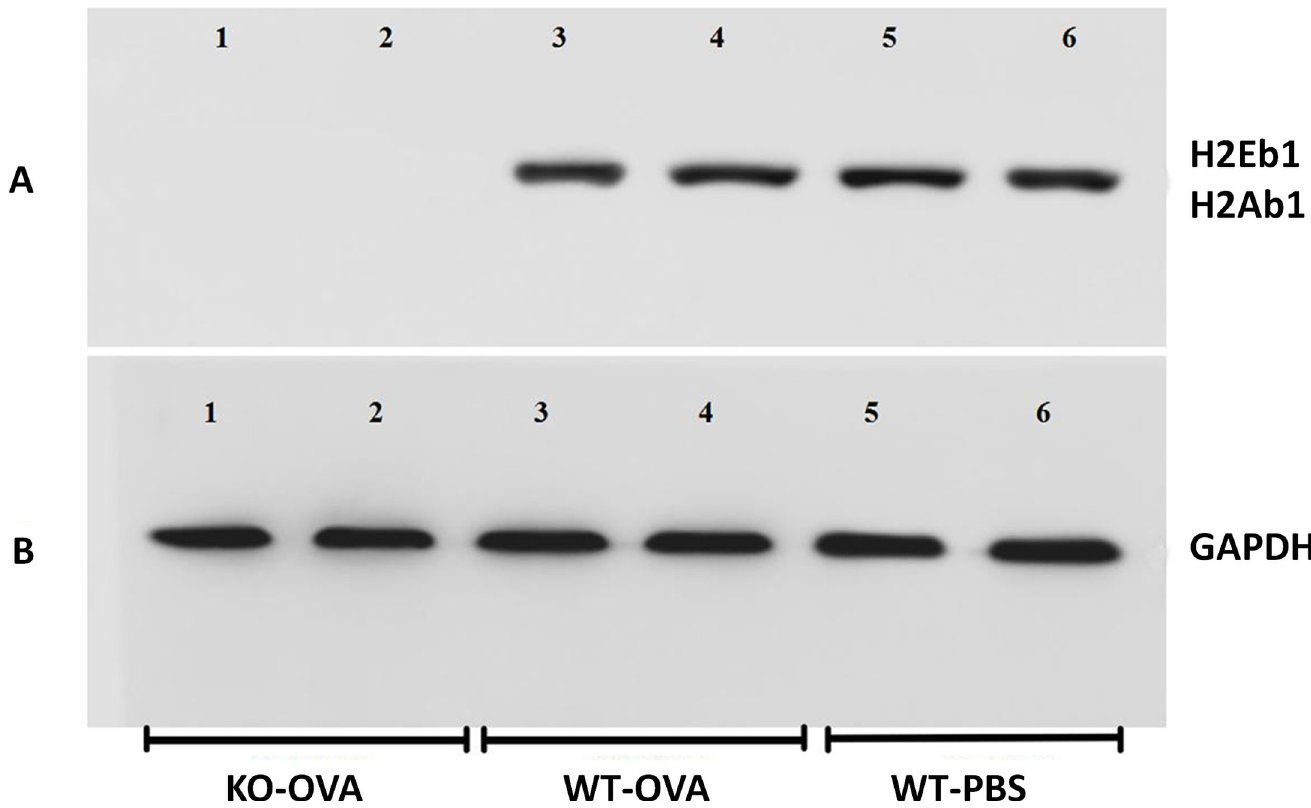
Fig 1. The expression of H2-Eb1 and H2-Ab1 in lung tissue samples from different groups of mice detected by Western blotting. In panel A, the first lane (KO-OVA mice) had no detectable H2-Eb1 protein expression, while the samples in the third lane (WT-OVA mice) and the fifth lane (WT-PBS mice) had H2-Eb1 protein expression. The second lane (KO-OVA mice) also had no detectable H2-Ab1 protein expression, while the samples in the fourth lane (WT-OVA mice) and the sixth lane (WT-PBS mice) had H2-Ab1 protein expression. Panel B shows the expression of GAPDH, which was used as a reference protein.